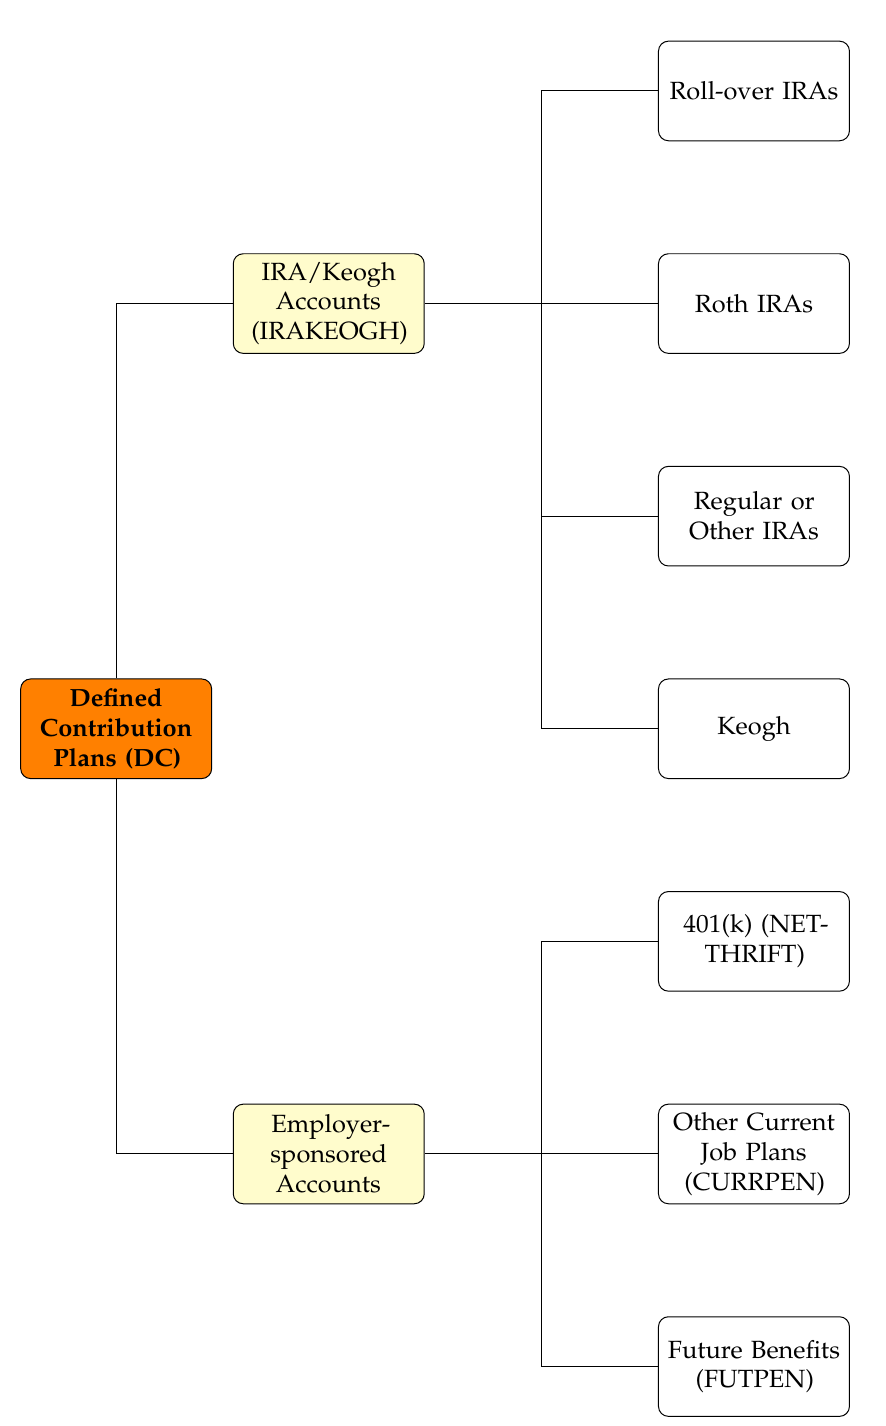
Figure 1. Defined Contribution Plans in the 2019 SCF. Source: U.S. Federal Reserve Boards’ Survey of Consumer Finances for 2019.